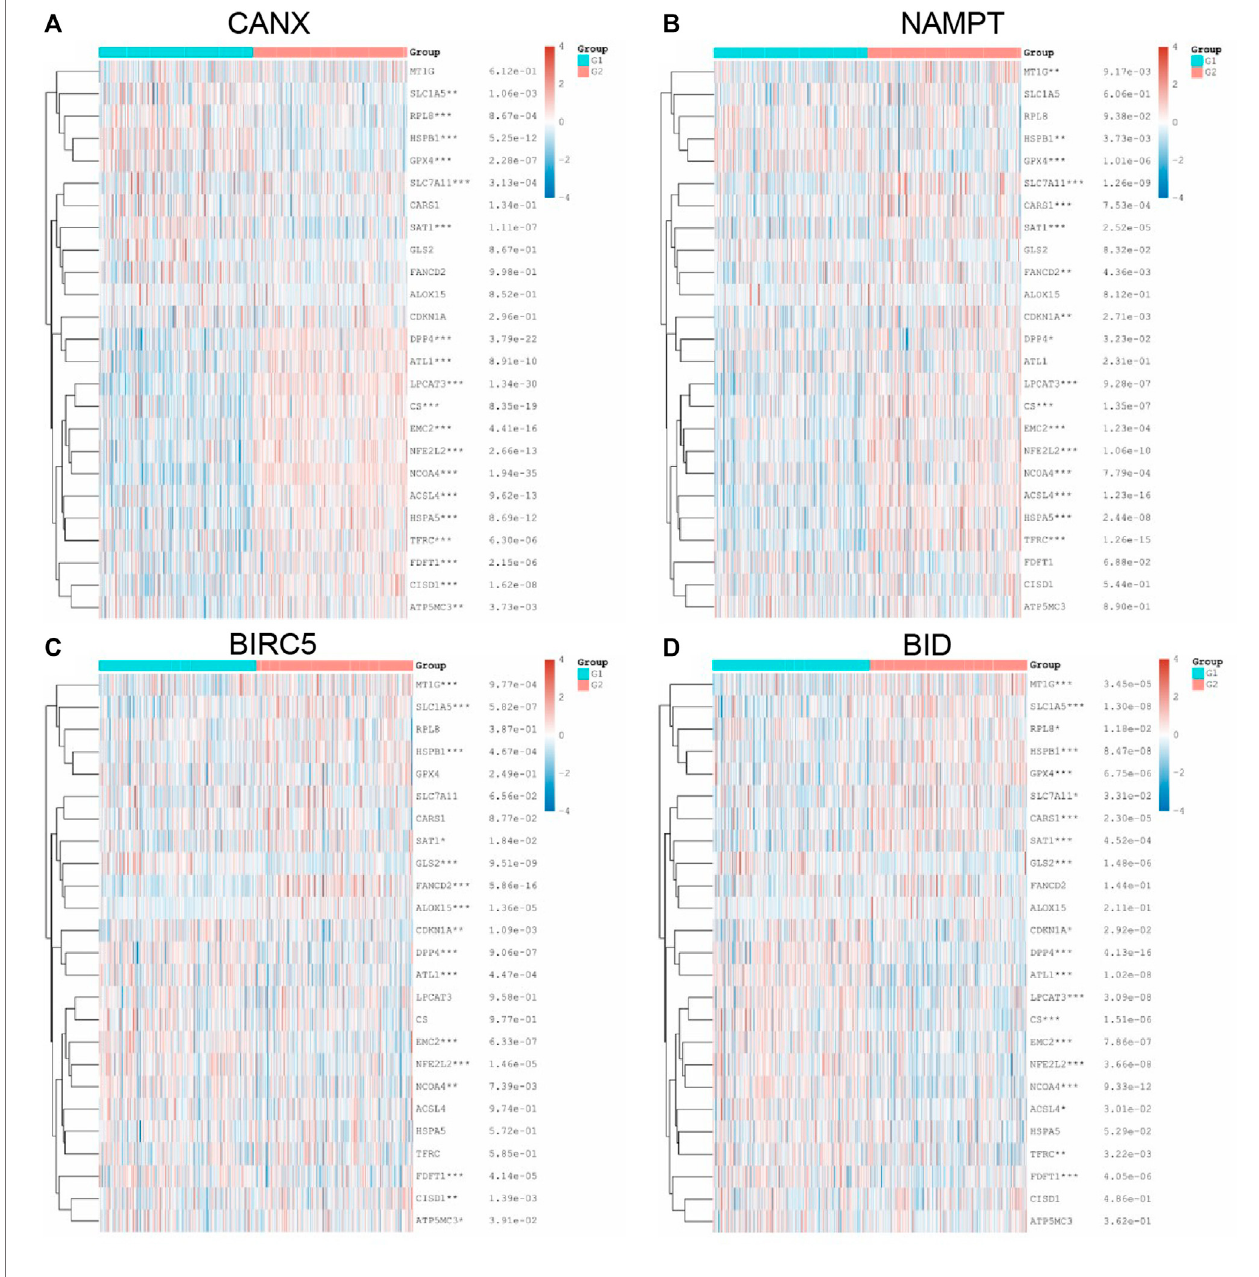
FIGURE 9 | Relationship between methylation, ferroptosis, and expression of immune-autophagy-related differentially expressed genes (DEGs). The difference of expression of ferroptosis-related genes in kidney renal clear cell carcinoma (KIRC) tissues with high and low CANX (A) , NAMPT (B) , BIRC5 (C) , and BID (D) gene expression. G1 is a low-expression group, and G2 is a high-expression